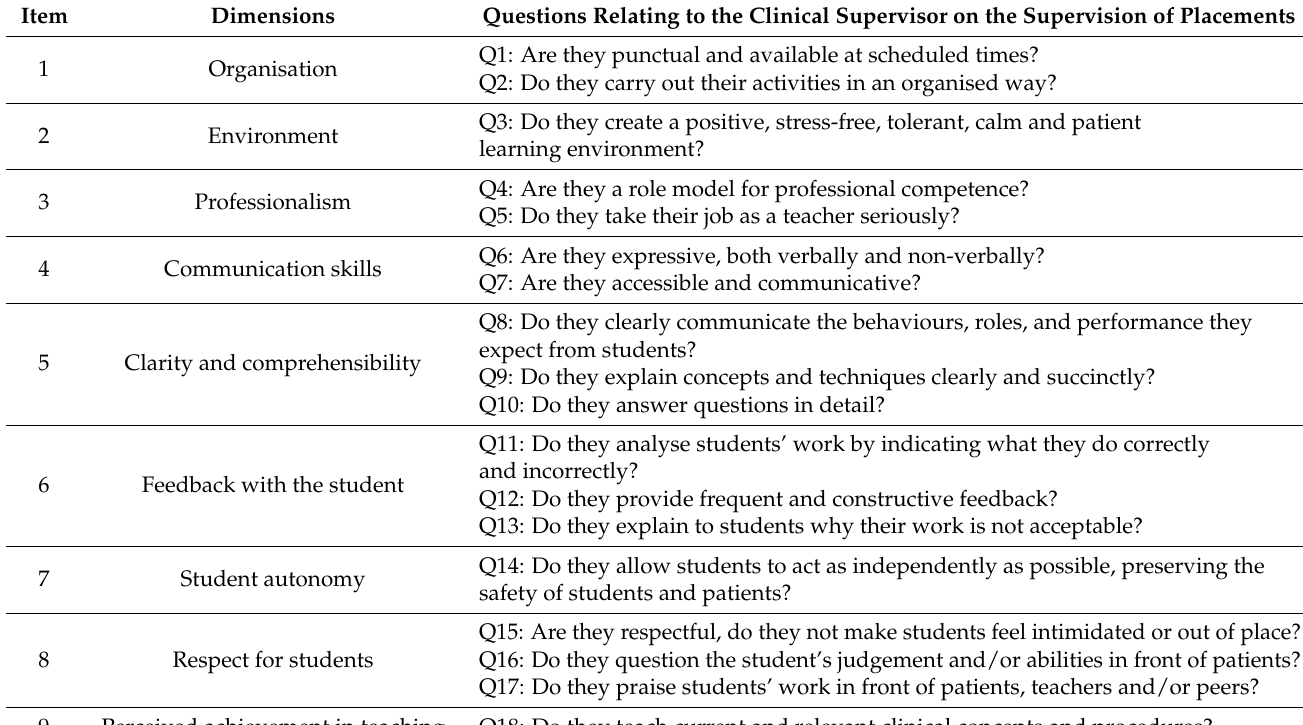
Table 1. Questionnaire on the role of the supervisor in